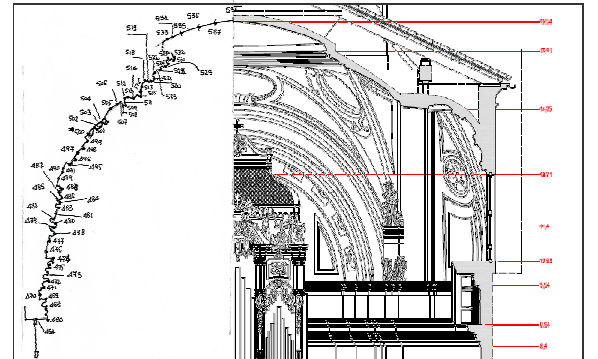
Figure 6 – Software Sir-IO, allows to operate directly on the three-dimensional model and specifically on the photo solid